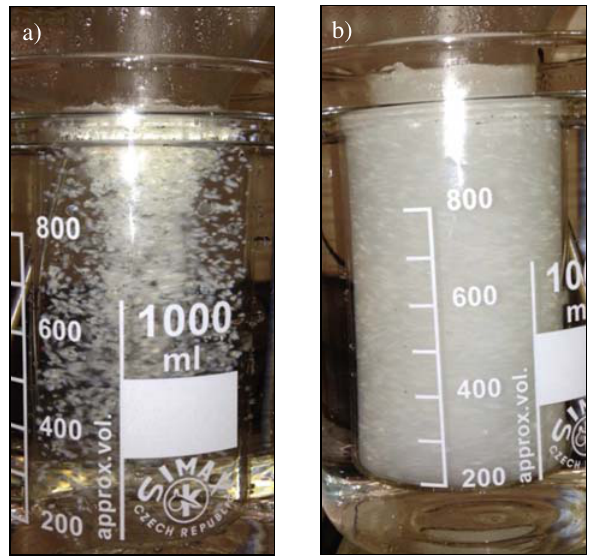
Figure 1. (a) Dispersion of the reagents after applying mixtrure of PVA and gelatin as a suspension agent. (b) Effect of usage of mix- ture of PVA and CaCl 2